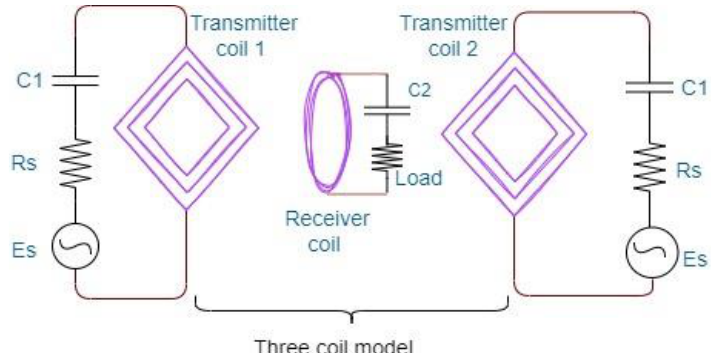
Figure 3. The model of three coil power transfer system.